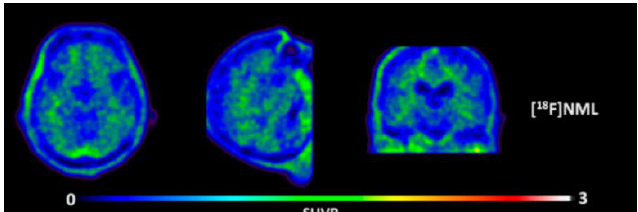
Figure 6. Representative transversal, sagittal, and coronal (18F)N-methyl lansoprazole (NML) PET images in a progressive supranuclear palsy patient for the detection of tau [70]. Images are reprinted with permission of the publisher [70].